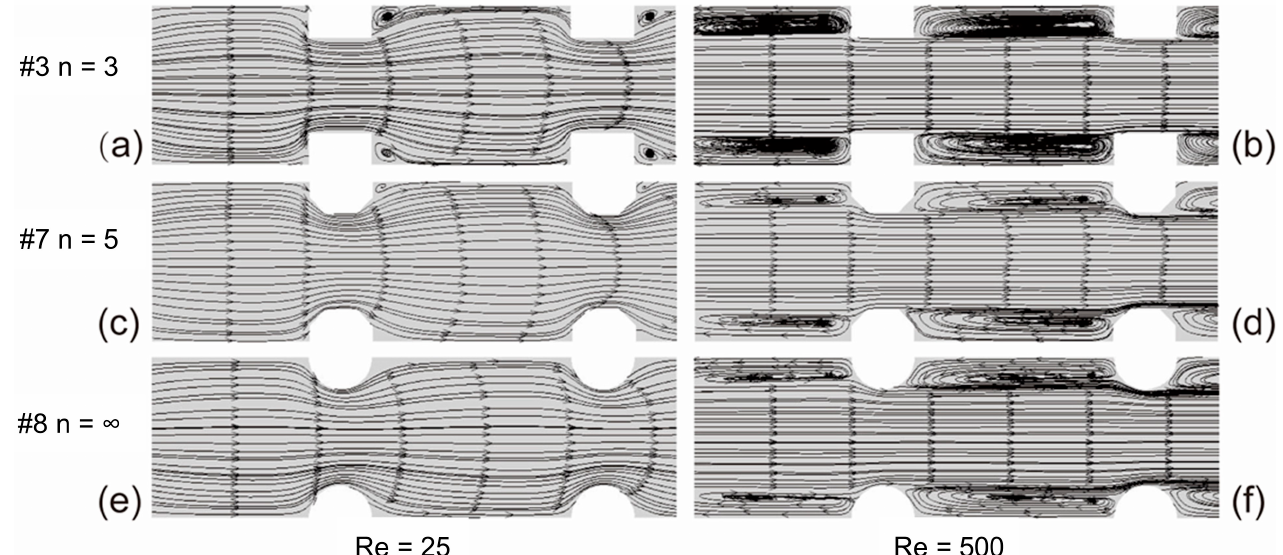
Figure 10. Streamlines in the transverse central section of the fluid with different fin smoothness: ( a ) n = 3, Re = 25; ( b ) n = 3, Re = 500; ( c ) n = 5, Re = 25; ( d ) n = 5, Re = 500; ( e ) n = ∞ , Re = 25; ( f ) n = ∞ , Re = 500.